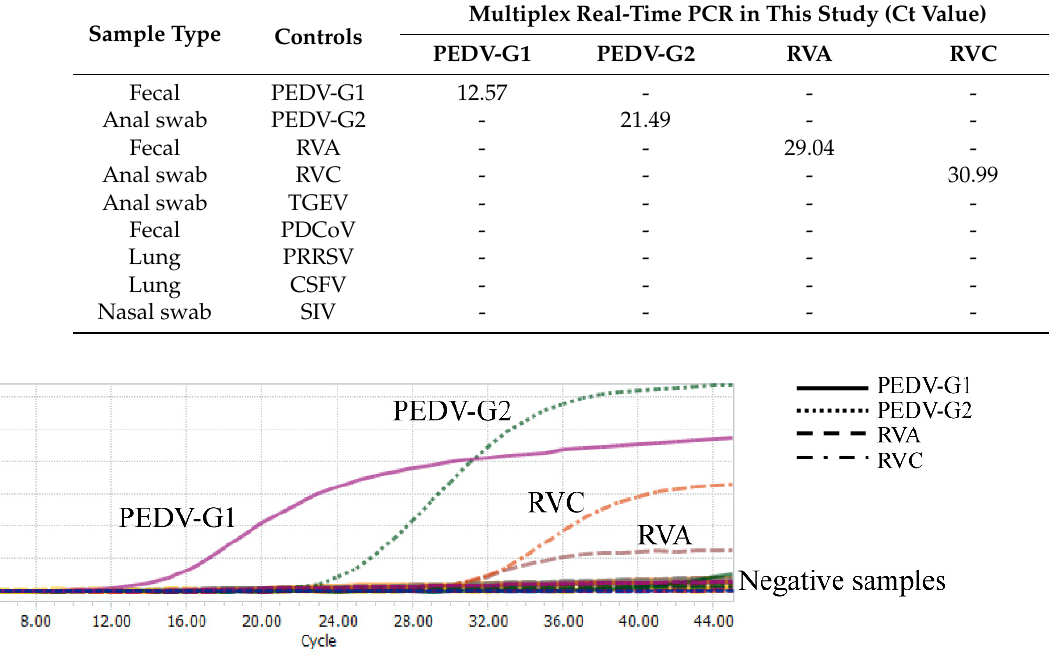
Figure 2. Analytical specificity of the multiplex real-time PCR. Four amplification curves (X-axis: cycle, Y-axis: fluorescence) representing samples positive for PEDV genotypes G1 and G2, and porcine group A and C rotaviruses. Negative samples included TGEV, PRRSV, CSFV, SIV, PDCoV, and the negative control.